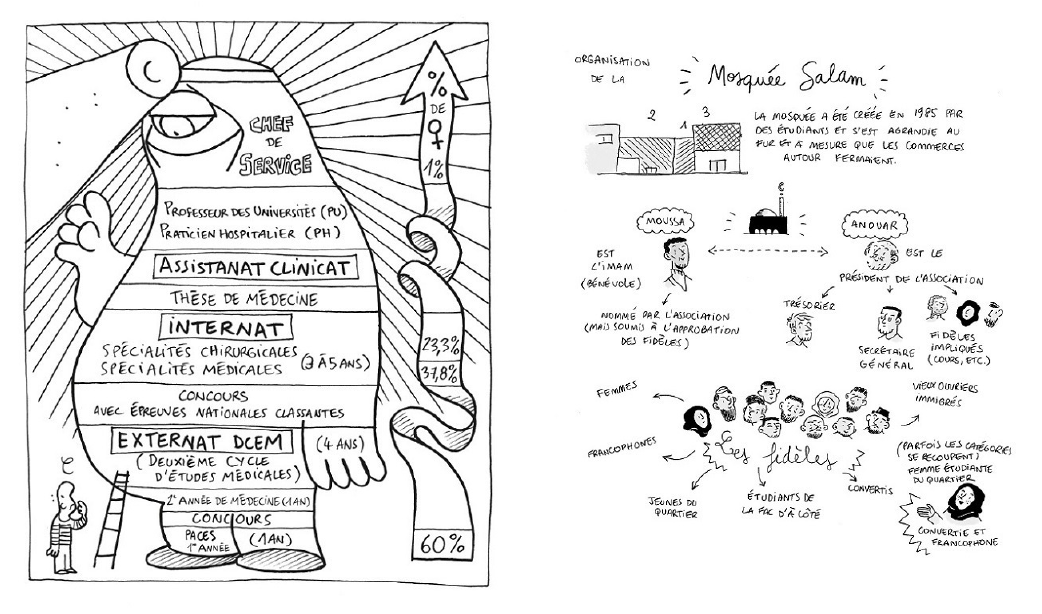
Figure 6: Sous la blouse, Zolesio/Mousse ©CASTERMAN (left); L’amour du Maillot, Rasera/Georges ©CASTERMAN